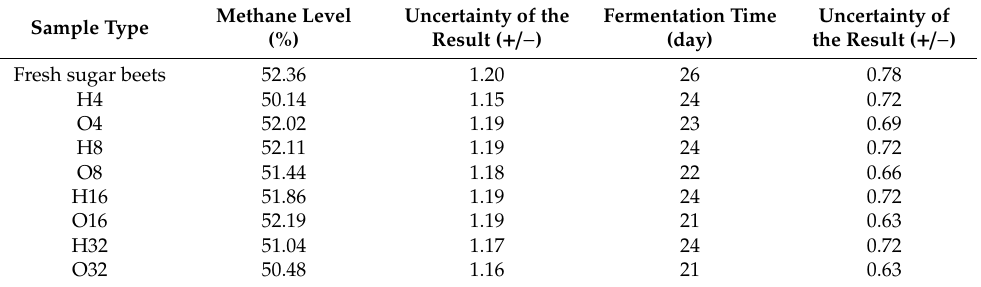
Figure 4. Cumulative biogas yield obtained from 1 mg of volatile solids (VS). Table 2. Methane content and fermentation time of the analyzed